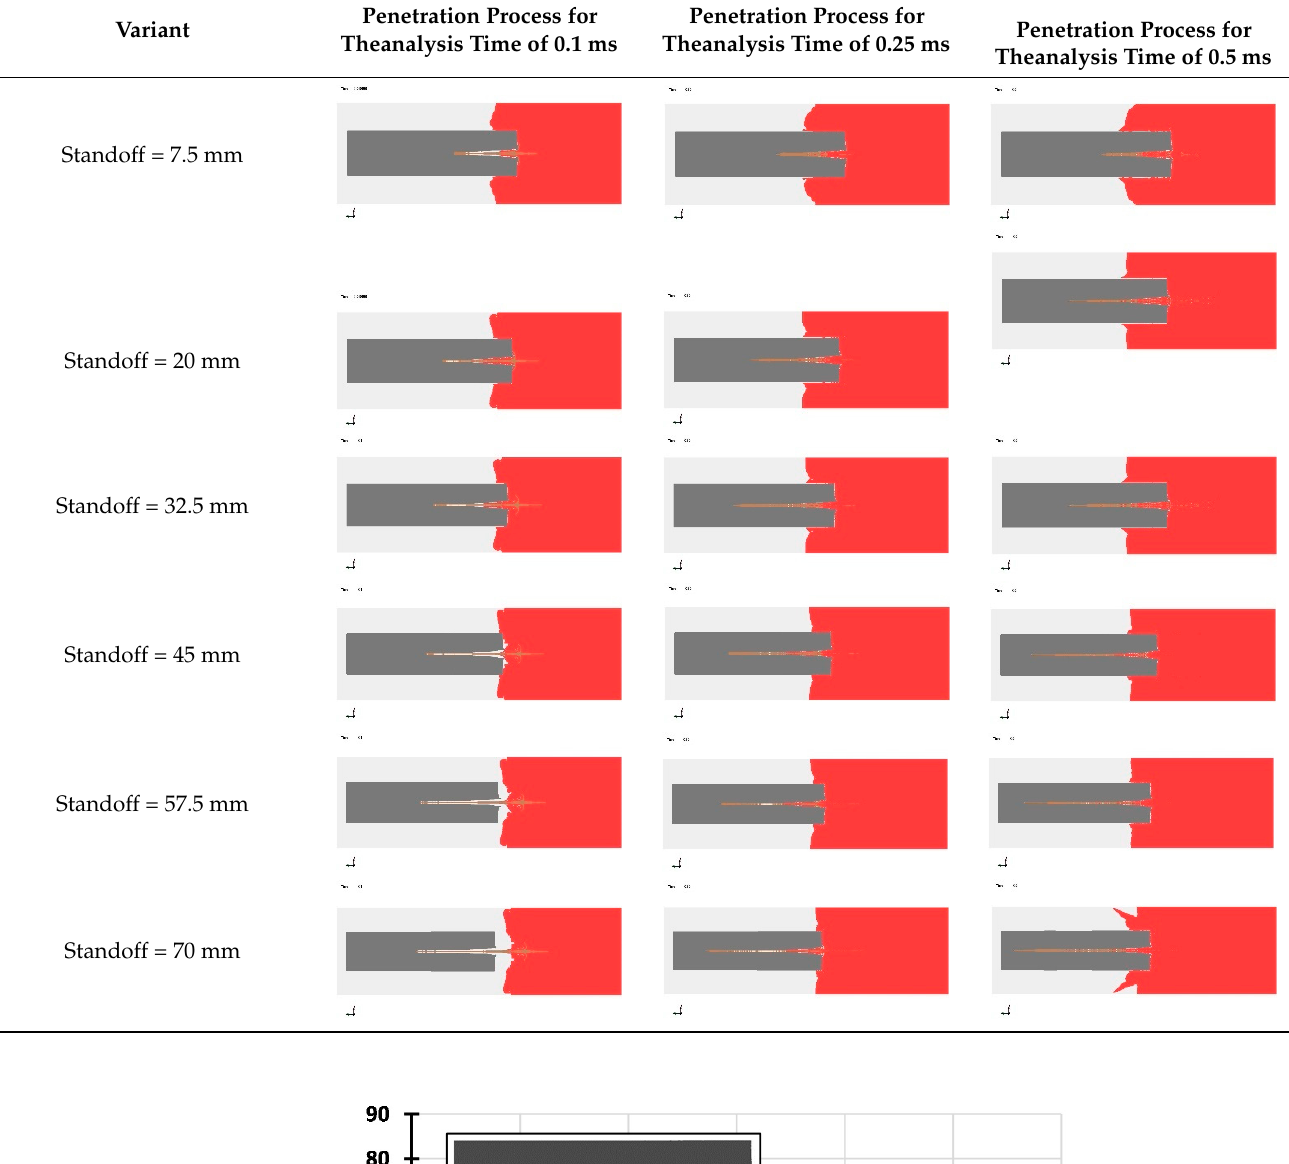
Table 8. View of the propagation process of detonation products and the penetration process of the shaped charge.